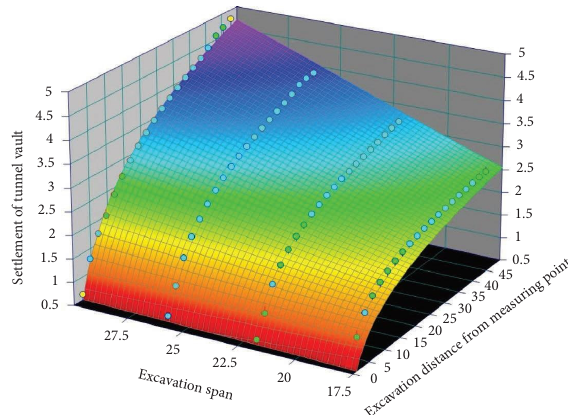
10: 3D model of tunnel vault settlement model